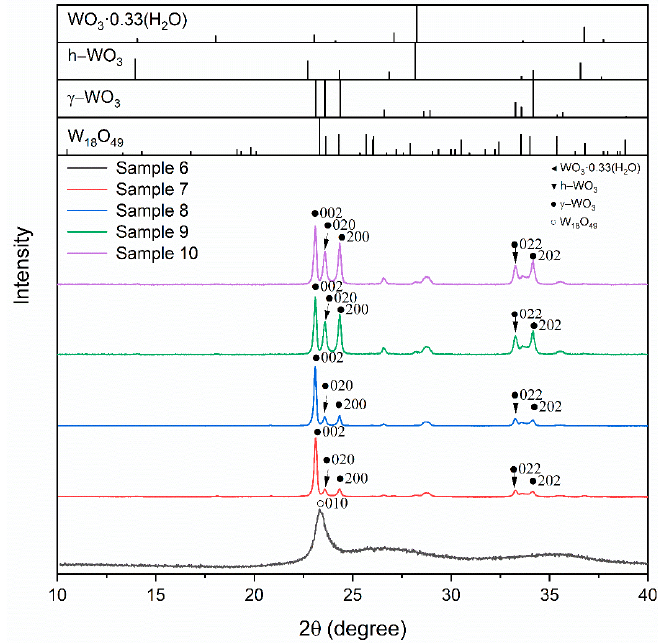
Figure 3. XRD data of samples 6–10 (see details in Table 1). For comparison: the top inset is the standard reference diffraction patterns of W 18 O 49 (JCPDS no. 36-0101), h-WO 3 (JCPDS no. 75-2187), WO 3 ·0.33(H 2 O) (JCPDS no. 87-1203), and γ -WO 3 (JCPDS no. 32-1295).